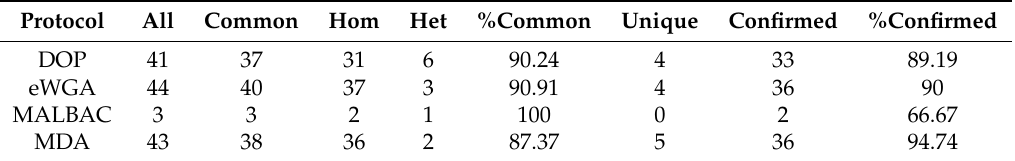
Table 1. Numbers of mtDNA variants detected in pairwise comparisons of HT-29 cells according to the following thresholds: depth of 30 reads and minimum allele frequency of 3%.